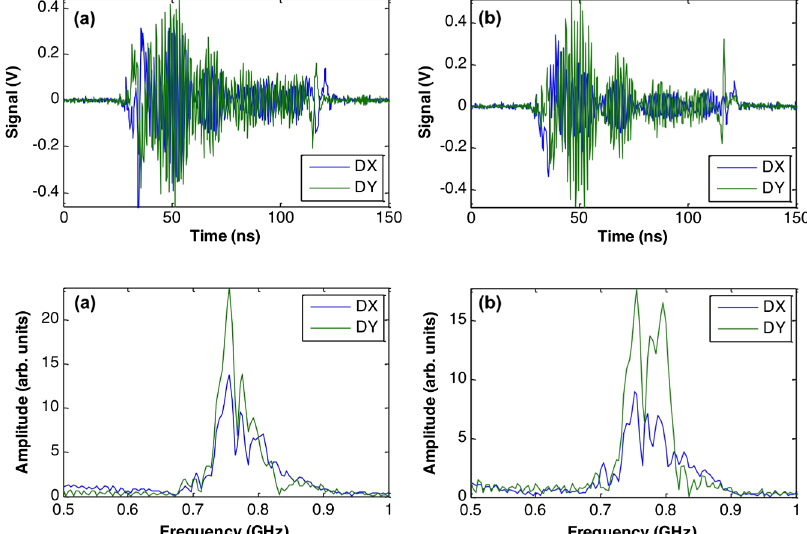
FIG. 11. Top row: unintegrated Δ x and Δ y signals measured at BPM20 ( z ¼ 36 . 1 m). Bottom row: fast Fourier transform of the signal above to indicate the amplitude and frequency of the BBU on the 2.9 kA beam for (a) the misaligned case and (b) the aligned case (note scale differences).